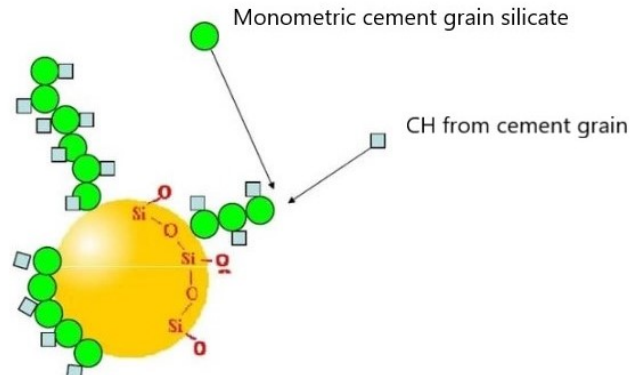
Figure 2. Mechanism of action of nanosilica. Monomeric silicates dissolved from the clinker phases are attracted by colloidal silica. The formed “silicate polymer” is stabilized with calcium hydroxide [manufacturer’s materials, www.akzonobel.com (accessed on 6 March 2021)].